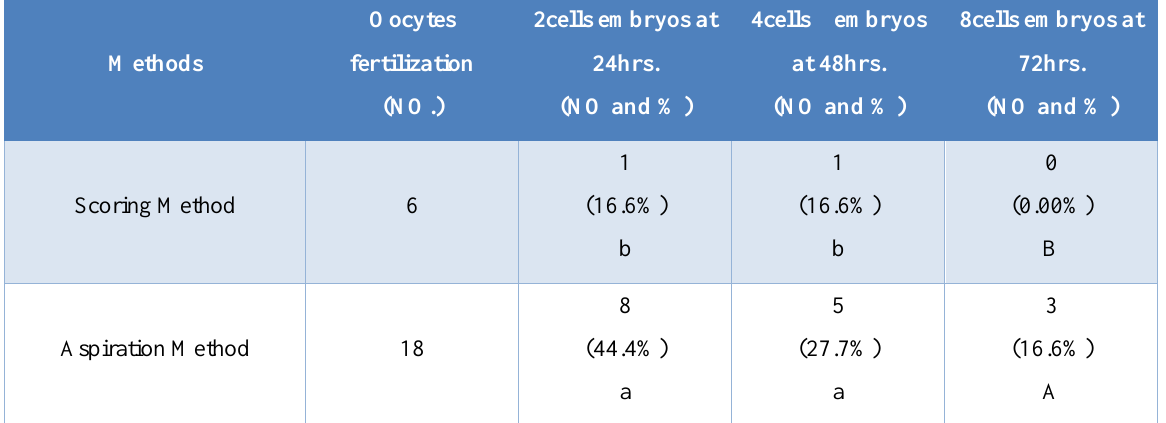
*Different small letters vertically denote significant (P>0.05) between methods of oocyte fertilization(X=0. 731). Table, 5: Effect of methods collection on Embryo development culture (IVC) of oocytes fertilization in different methods .